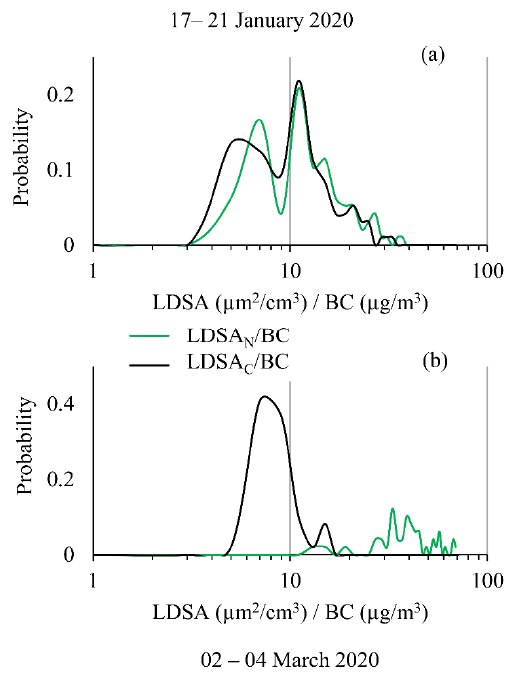
Figure 9. Probability distribution of the LDSA to BC ratio calculated for both CS and No CS Naneos’ shown on a logarithmic scale for ( a ) 17–21 January 2020 and for ( b ) 2–4 March 2020.